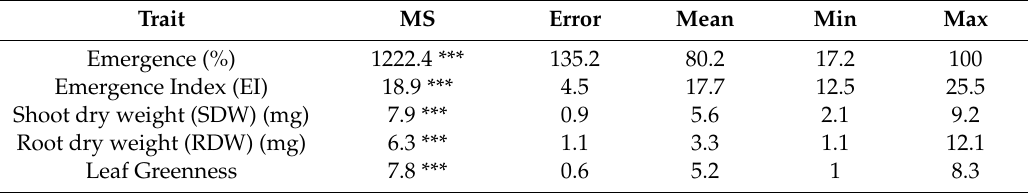
Table 5. Genotypic variances (mean squares, MS) and descriptive statistical traits for the climate chamber experiment (df = 329). Genotypic variances were computed using a general linear model in which genotypes were considered as fixed and replicates as random e ff ects (see Material and Methods). Trait